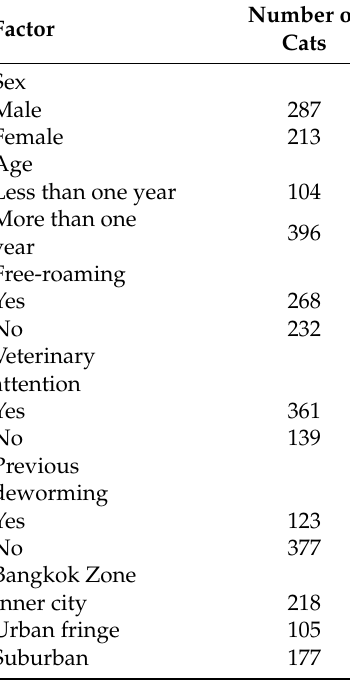
Table 2. Risk factor association with hookworm infected in semi-domesticated temple cats, Bangkok,